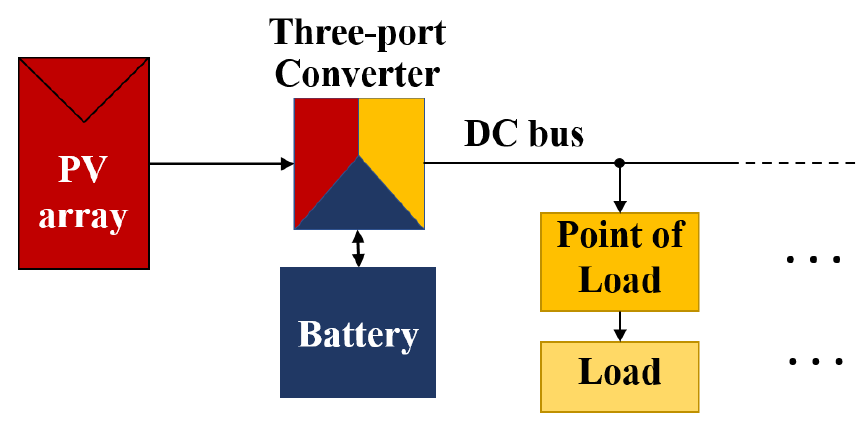
Figure 1. The islanded DC nanogrid considered.